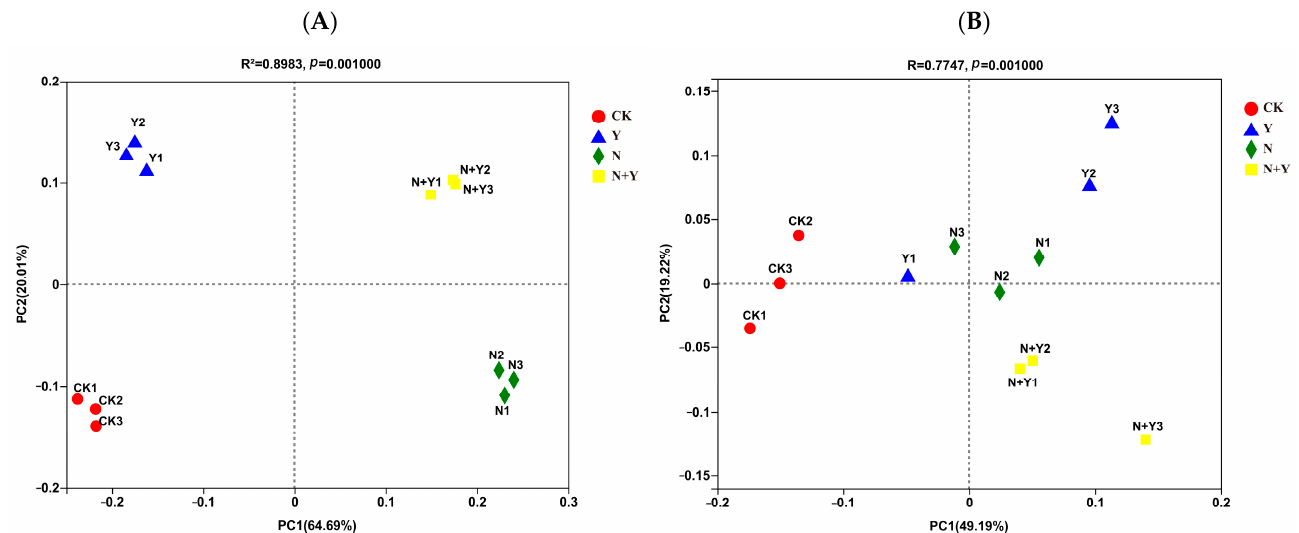
Figure 4. Principal coordinate analysis based on the distance matrix calculated using the Bray–Curtis algorithm for samples collected from different treatments. Different treatments: CK (control), seedlings were irrigated with normal nutrient solution; Y, control + B. subtilis K424; N, four-strength control; N + Y, four-strength control + B. subtilis . K424 ( A ) bacteria; ( B ) fungi.